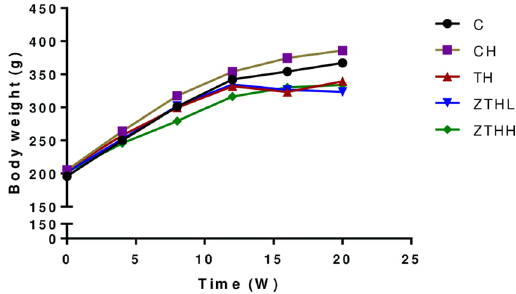
Figure 2. Effect of zinc selenium tea on the body weight in experimental groups (g, mean and SEM, n = 10).